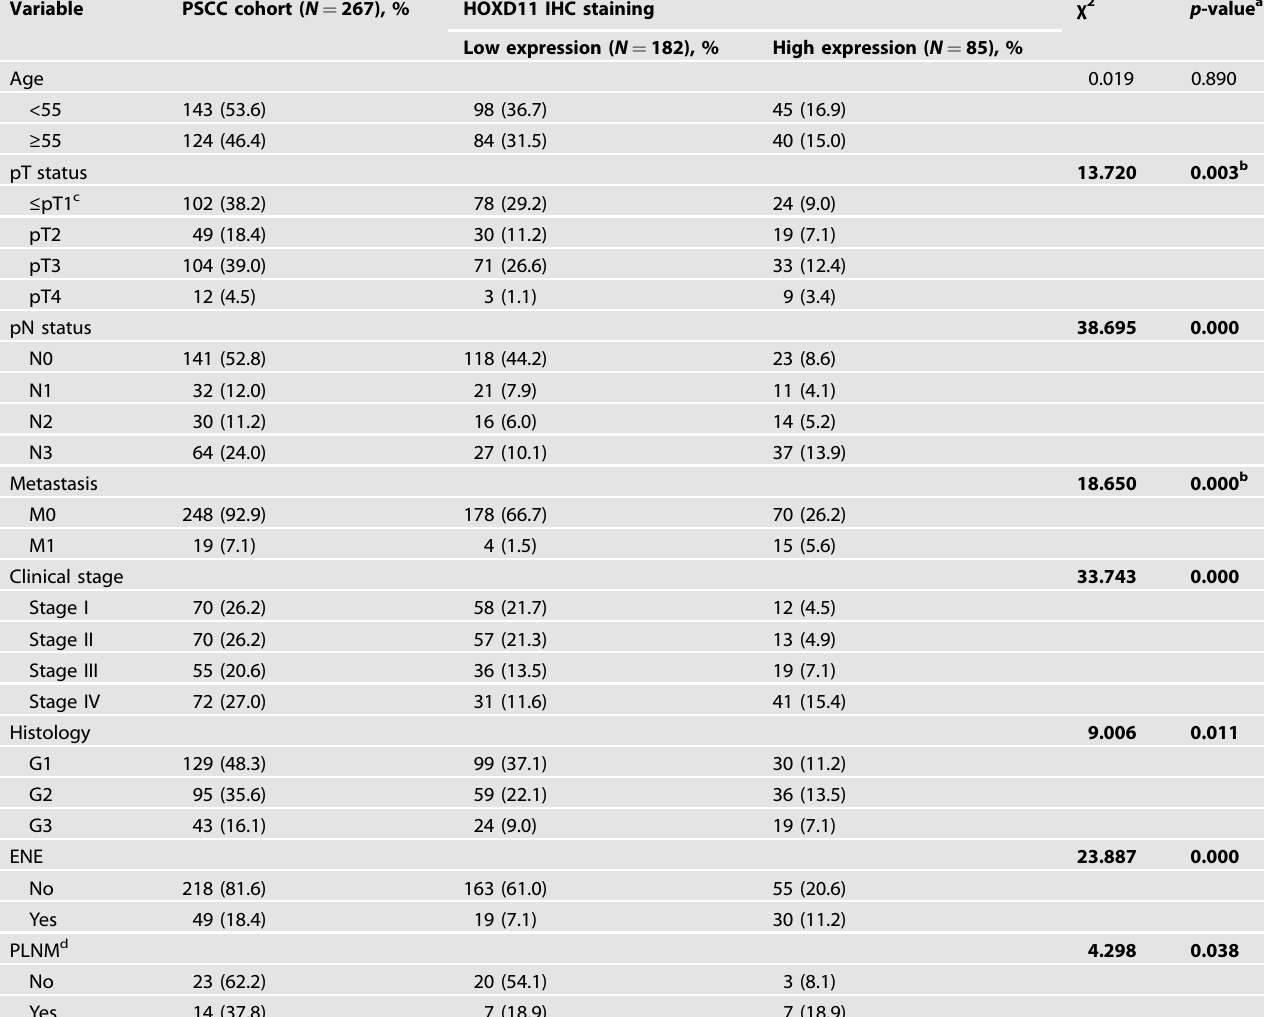
Table 1. Clinicopathological characteristics and the association with HOXD11 expression in 267 PSCC